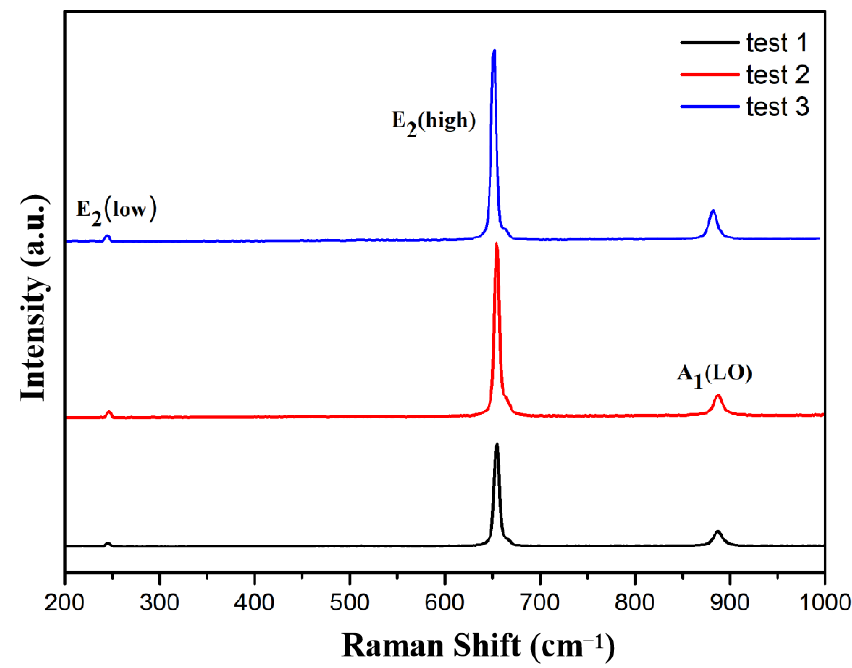
Figure 9. Raman spectrum of AlN wafer.